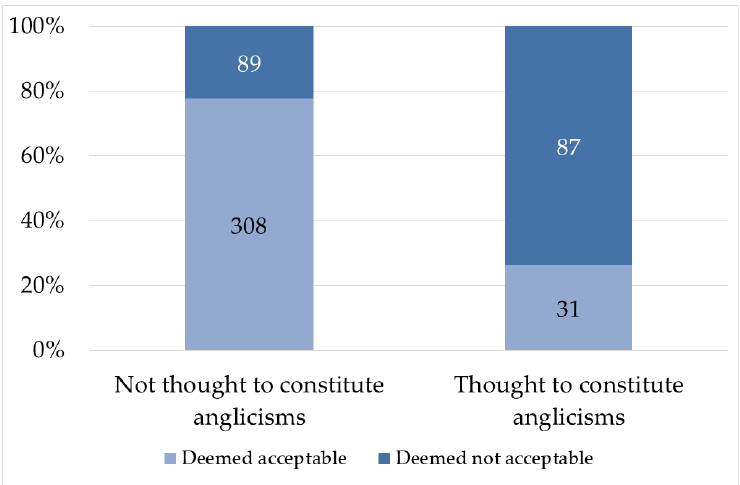
Figure 1 . Feature acceptability as a function purported relation to English. Figure 1. Feature acceptability as a function of purported relation to